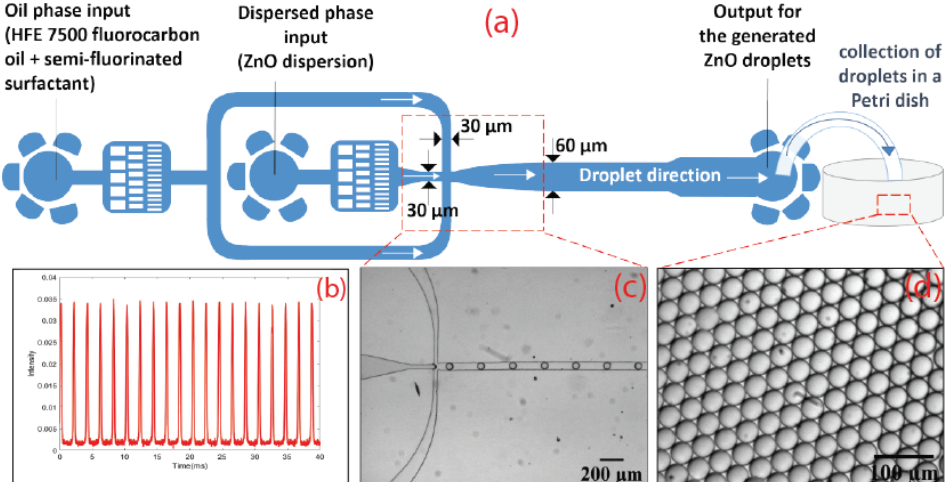
Figure 2. ( a ): Schematic illustration of the flow-focusing microfluidic design used for the production of zinc oxide droplets (and microcapsules); ( b ) real-time fluorescence detection of flowing droplets using rhodamine B dye and our optofluidic setup; ( c , d ): optical micrographs of monodisperse zinc oxide droplets in the microfluidic channel and in the Petri dish,